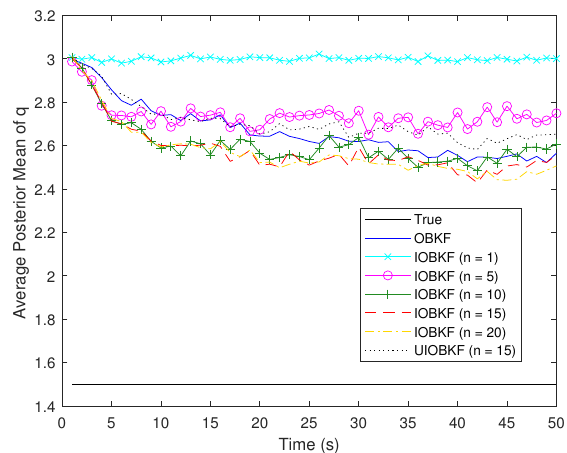
Figure 5. Estimation of noise parameter q .